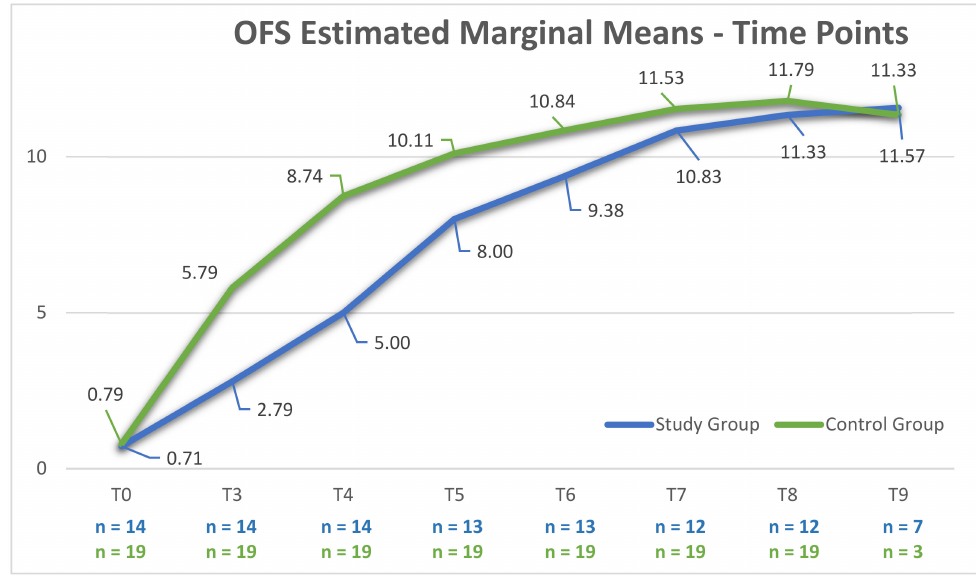
Figure 11. Evolution of the Open Field Score (OFS)-estimated marginal means in both the study and control groups throughout intensive neurorehabilitation. Y -axis: OFS; T0 (day 0); T1 (day 1); T2 (day 2); T3 (day 3); T4 (day 5); T5 (day 7); T6 (day 14); T7 (day 21); T8 (day 30); T9 (day 60).